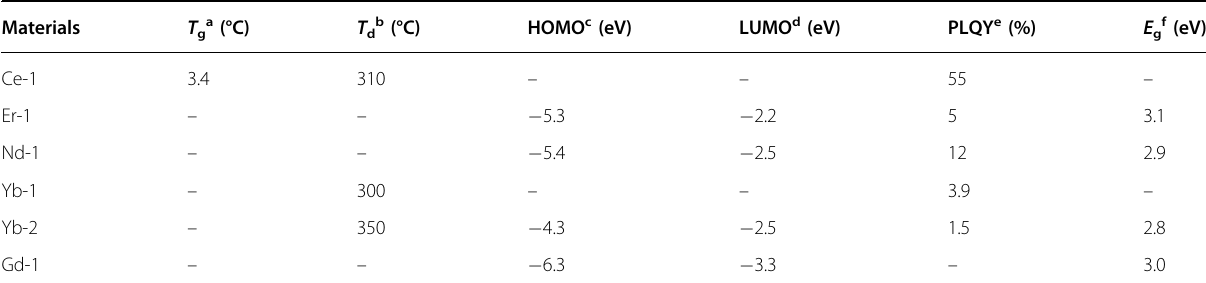
Table 4 The physicochemical properties of the representative other RE complexes